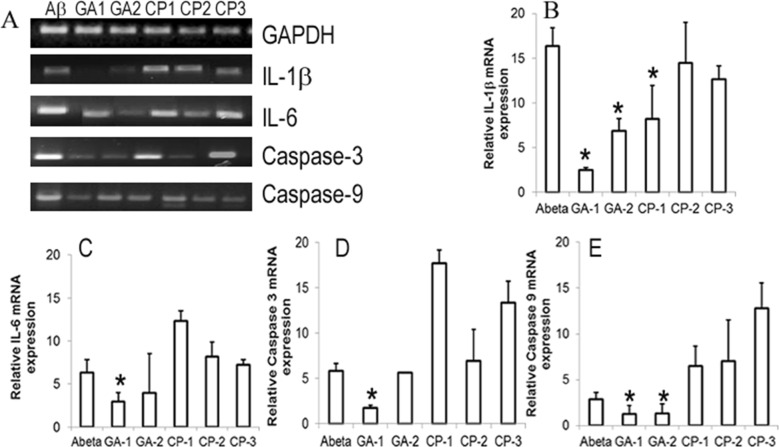
Effect of GILZ analog (GA) treatment on apoptosis related molecules in human fetal brain cells: Primary cultures of HFB were exposed to Aβ1–42 and treated with 50μM of indicated GA or control peptide (CP).Total RNA was isolated from cells harvested after 24h and assessed for mRNA for IL-1β, IL-6, Caspase-3 and Caspase-9 by quantitative PCR. The mRNA expression in each sample was finally determined after correction with GAPDH expression. (A) Gel electrophoresis of the PCR products GAPDH (111bp), IL-1β (89bp), IL-6 (260bp), Caspase-3 (165bp) and Caspase-9 (162bp). (B) Relative mRNA quantitation of IL-1β (B), IL-6 (C), Caspase-3 (D) and Caspase-9 (E) with respect to that of housekeeping gene GAPDH is shown. Data are average of two experiments and expressed as means ±SD. * = p<0.05 with respect to vehicle treated cells.